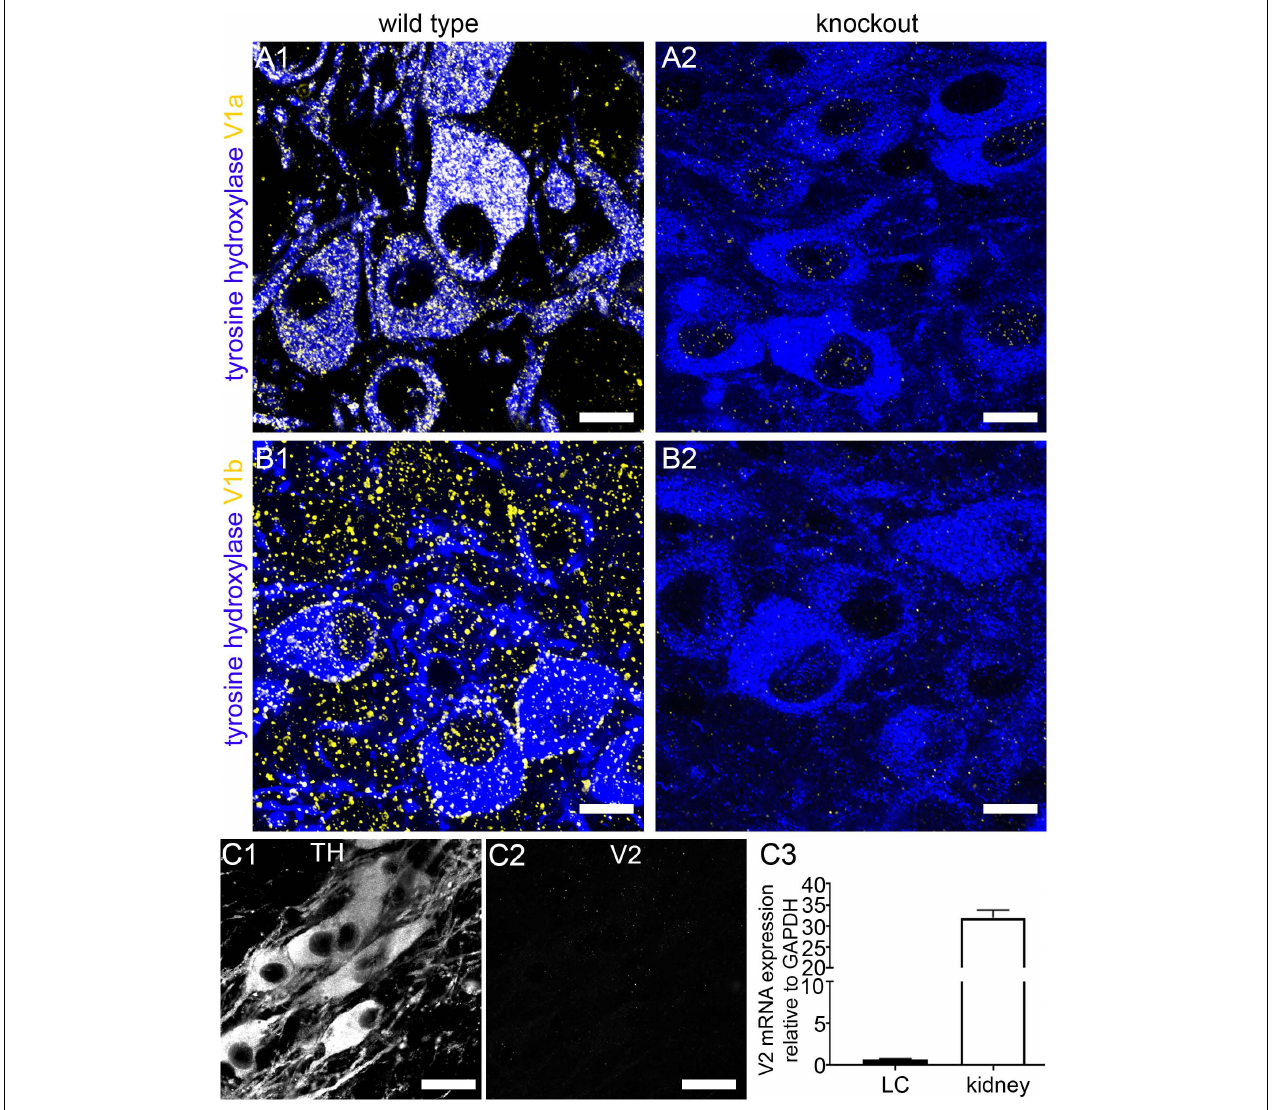
FIGURE 1 | Confirmation of the specificity of the V1a and V1b receptor antibody labeling in the LC. (A1) Shows immunoreactivity for tyrosine hydroxylase (TH) (blue) and the V1a receptor (yellow) in tissue from WT mouse. TH is the enzyme essential for noradrenaline synthesis and thus identifies the principal neurons of the LC. V1a signal is exclusively associated with TH-immunopositive profiles. (A2) Shows, immunoreactivity for TH (blue) and V1a receptor (yellow) in tissue from a V1a knock out mouse. Only weak, non-specific nuclear signal is evident confirming the specificity of the V1a antibody labeling pattern. (B1) Shows immunoreactivity for tyrosine hydroxylase (TH) (blue) and the V1b receptor (yellow) in tissue from WT mouse. V1b signal is associated with TH-immunopositive cells as well as areas not containing TH-immunopositive profiles. (B2) Shows, immunoreactivity for TH (blue) and V1b receptor (yellow) in tissue from a V1b knock out mouse. Only weak, non-specific signal is evident confirming the specificity of the V1b antibody labeling pattern. (C1) Shows TH immunoreactivity. (C2) Shows, in the corresponding field of view, labeling for an antibody against the V2 receptor. No specific signal was detectable. (C3) Shows the expression of mRNA for the V2 receptor in tissue from the LC and the kidney which is known to express this receptor subtype. Whilst robust mRNA expression was detected in kidney, negligible expression was evident in LC samples. N = 5 animals, with the bars representing the means and the error bars, the SEM. Scale bars (A,B) , 10 µ m; (C) 20 µ